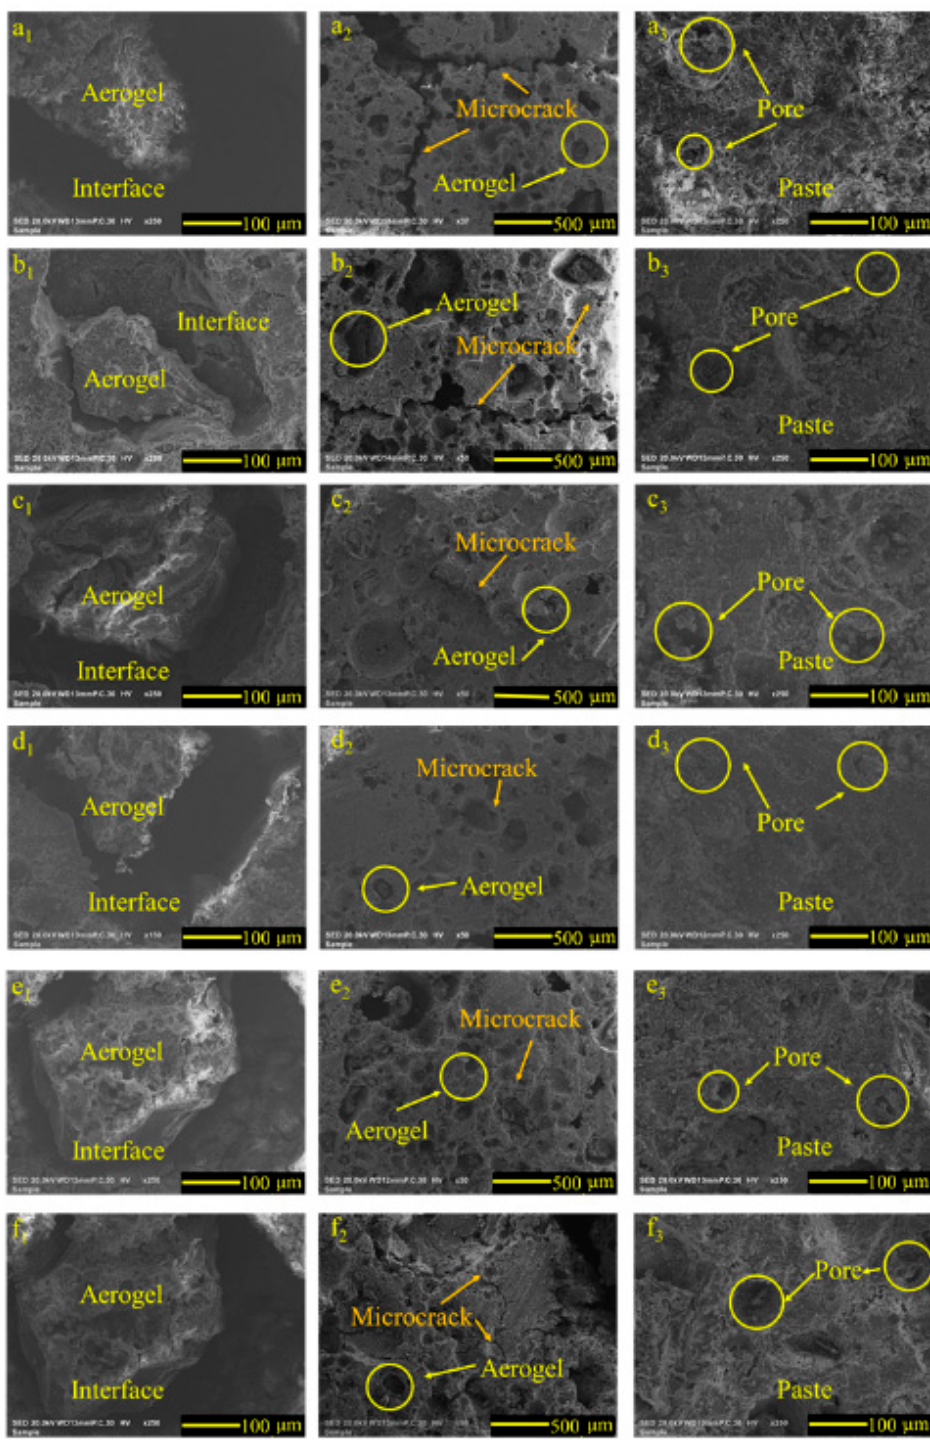
Figure 10. SEM images of ACP under different early curing regimes after the simulated tunnel fire: ( a 1 ) interface under 10 °C; ( a 2 ) aerogel under 10 °C; ( a 3 ) paste under 10 °C; ( b 1 ) interface under 20 °C; ( b 2 ) aerogel under 20 °C; ( b 3 ) paste under 20 °C; ( c 1 ) interface under 30 °C; ( c 2 ) aerogel under 30 °C; ( c 3 ) paste under 30 °C; ( d 1 ) interface under 40 °C; ( d 2 ) aerogel under 40 °C; ( d 3 ) paste under 40 °C; ( e 1 ) interface under 50 °C; ( e 2 ) aerogel under 50 °C; ( e 3 ) paste under 50 °C; ( f 1 ) interface under 60 °C; ( f 2 ) aerogel under 60 °C; ( f 3 ) paste under 60 °C.